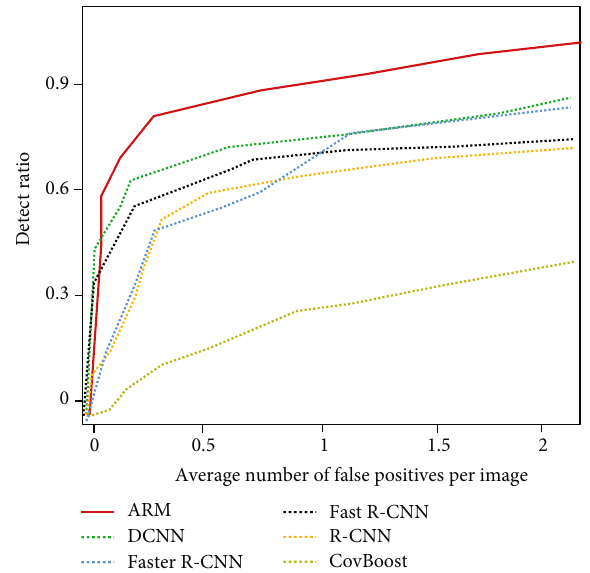
Figure 9: ROC curve of the recognition method on the dataset (ARM changed to SSD-MobileNet).